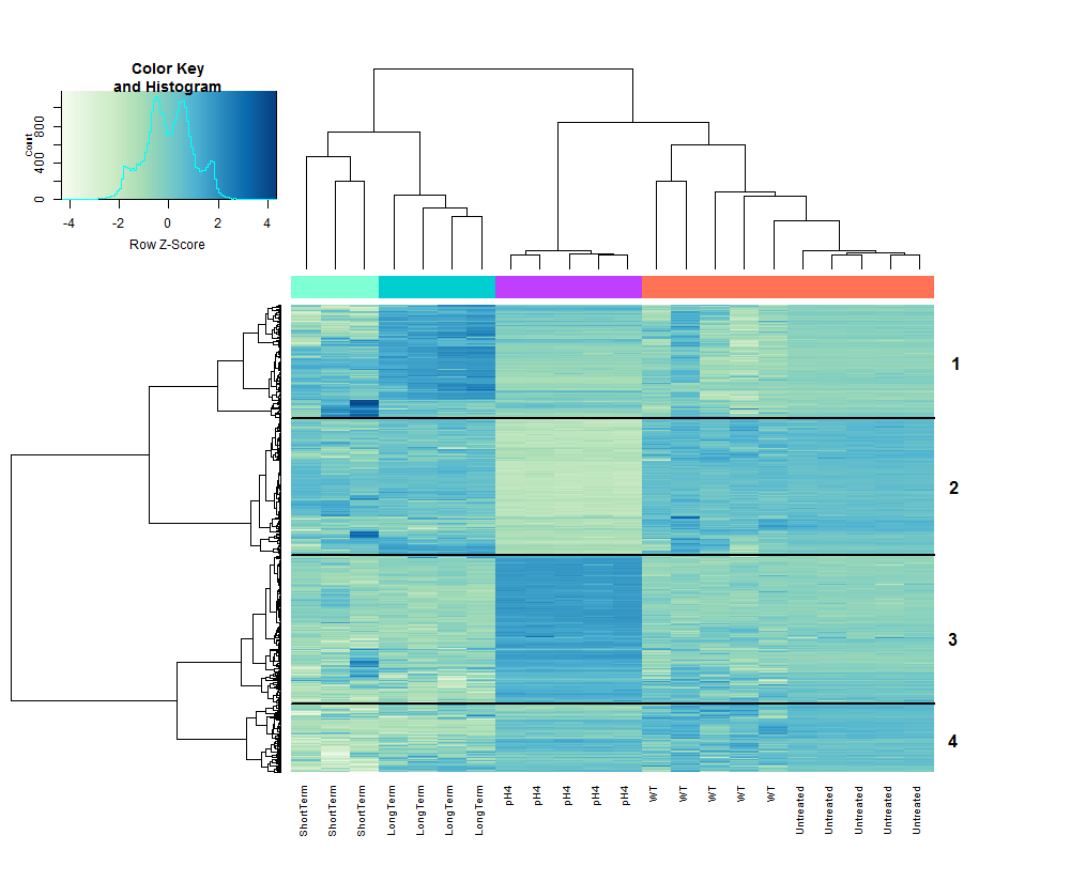
Figure 5. Heatmap showing the expression profiles of 1256 genes that were di ff erentially expressed (DE) (green: downregulated; blue: upregulated) in at least one of the analyzed groups (neutral pH: red bar; acidic pH: purple bar; short-term infection: turquois bar; and long-term infection: green bar). The neutral pH group was subdivided to either “WT”—control samples provided by Boggiatto et al. [29] or “Untreated”—control samples from our study [27]. Rows indicate genes and columns indicate bacterial samples. Green and blue pixels indicate downregulated and upregulated genes, respectively. The hierarchical clustering was generated by using the 1-Pearson correlation as the distance measure and “ward.D2” as the linkage method. Genes were categorized into four clusters based on the generated